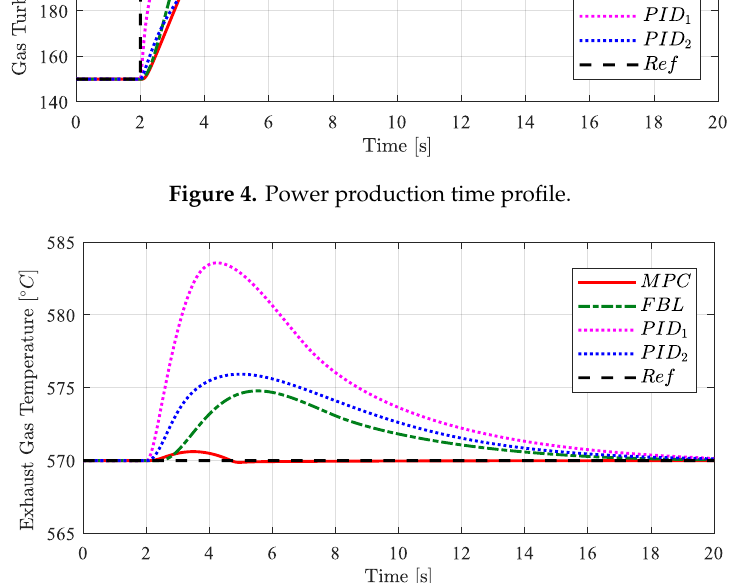
Figure 5. Exhaust gas temperature (EGT) time profile.